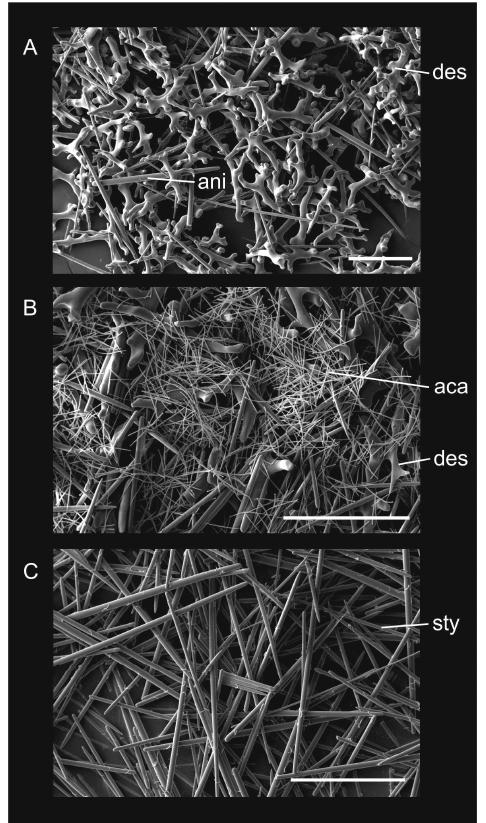
Figure 2. Scanning electron microscope images of subsamples from DH19-2 Asbestopluma sp. (a) internal framework section A, near the base; (b) external section A, near the base; (c) internal section E, the growing tip abbreviations: des = desma, ani = anisostrongyles, aca = acanthotylostrongyles, sty = styles.